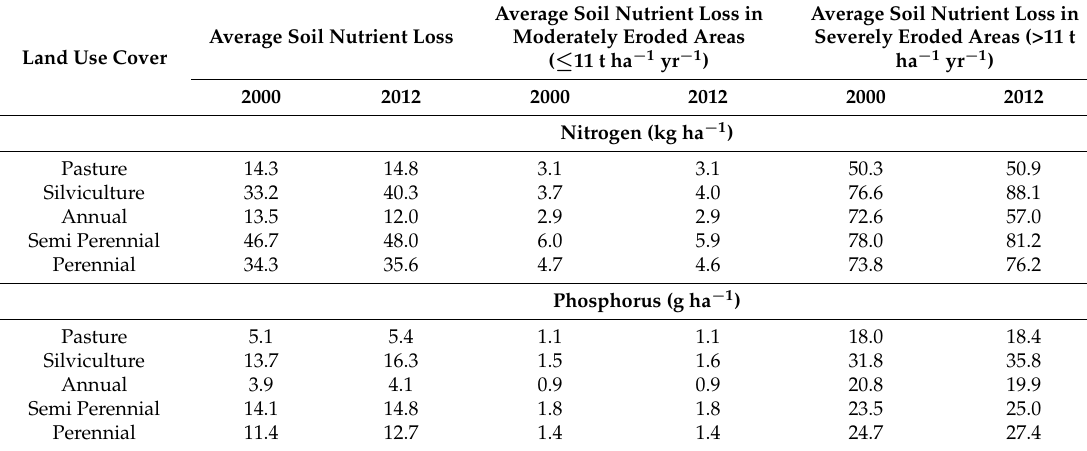
Table 10. Simulated potential nutrient loss rates (kg ha − 1 for N and g ha − 1 for P) for agricultural lands of the Brazilian Cerrado for the years 2000 and